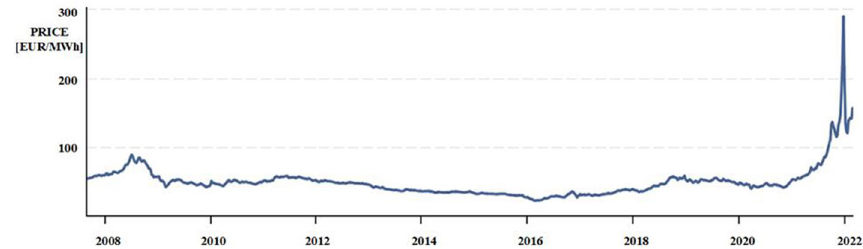
Figure 5. Evolution of the electricity price on the commodity exchange in EUR per 1 MWh 20